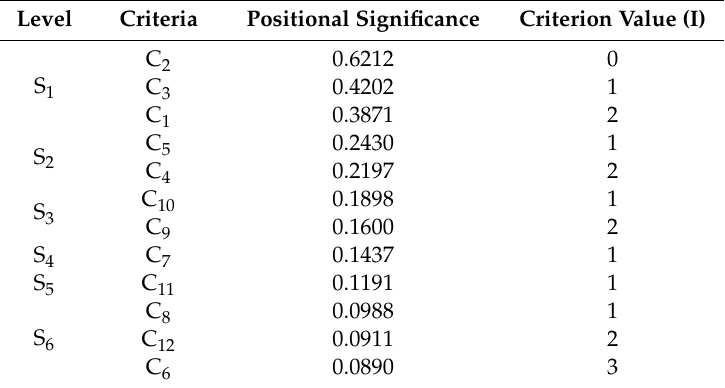
Table 9. LBWA calculations.